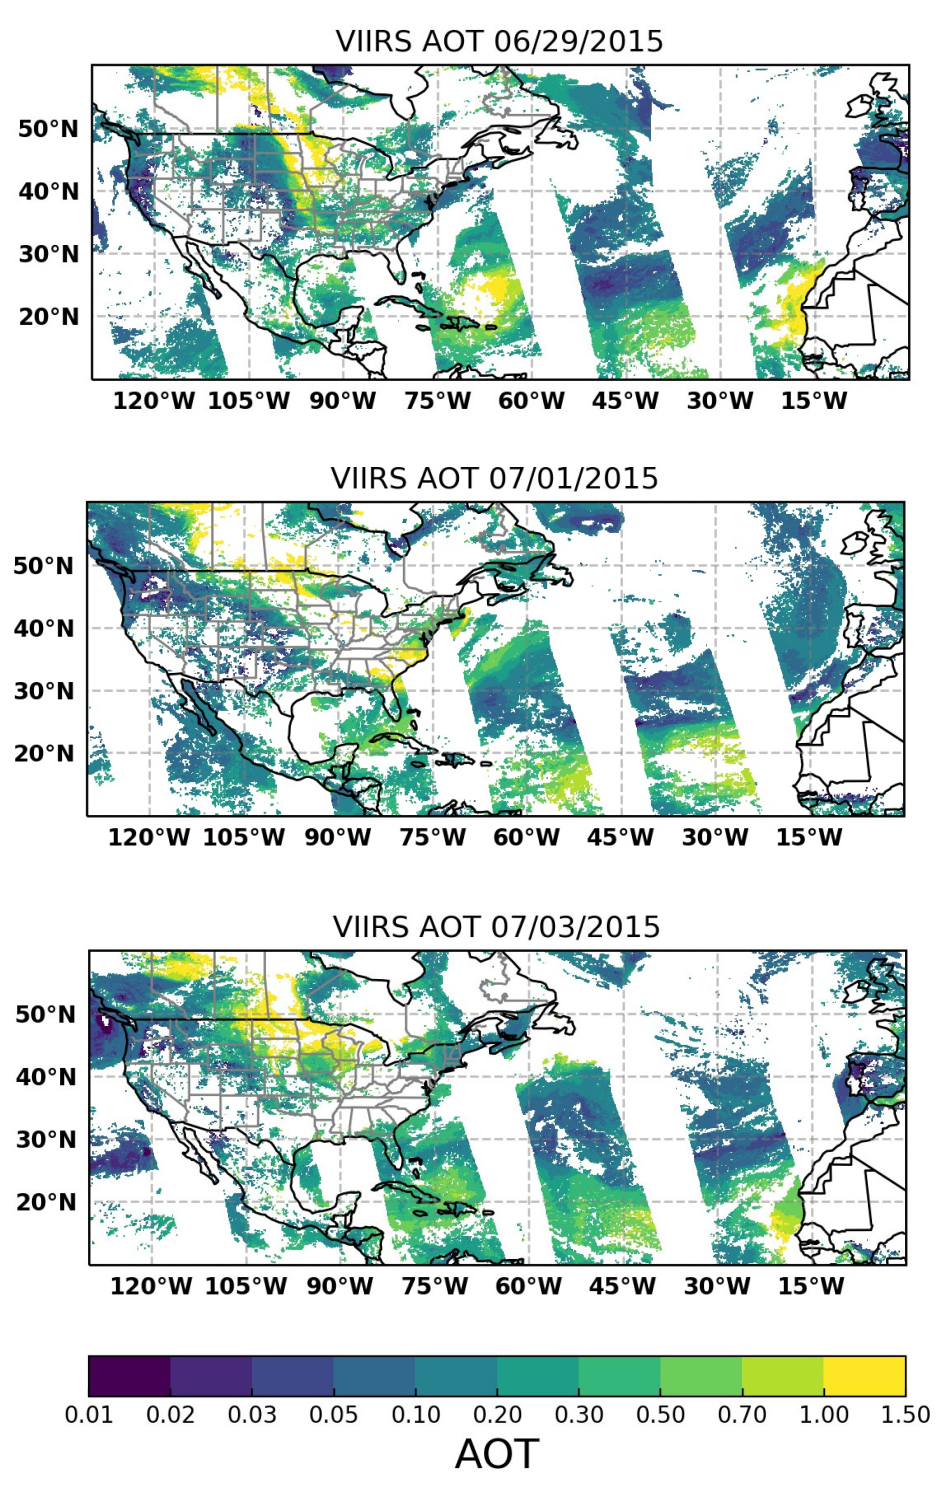
Figure 2. Suomi NPP VIIRS aerosol optical thickness (AOT) on 29 June, 1 July, and 3 July 2015. Please note that the dates in this figure are given in the format of month day year (mm/dd/yyyy). This figure is plotted using cartopy https://scitools.org.uk/cartopy/docs/latest/ (last access: February 2021), which uses the national and state border information from http://www.naturalearthdata.com/ (last access: Febru- ary 2021). Please note that the above figure contains incomplete US state borders and disputed